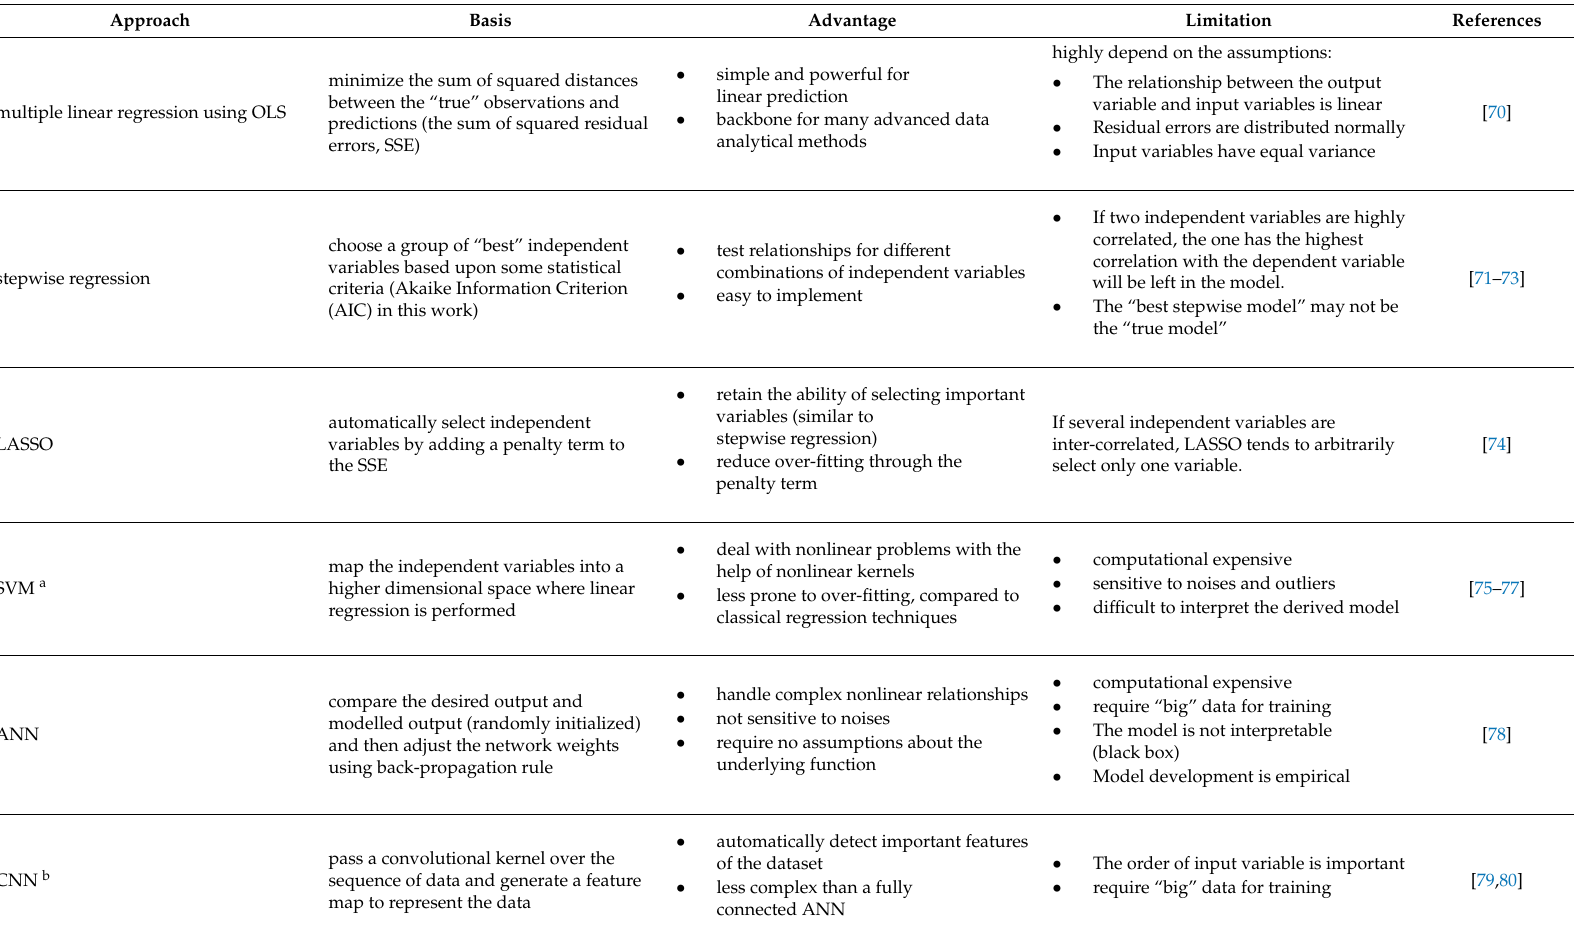
Table 3. Comparison of di ff erent data analytical